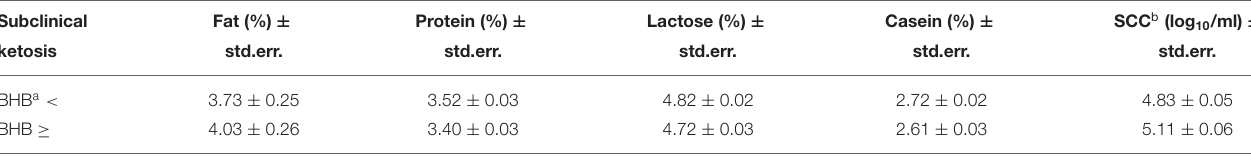
TABLE 3 | Estimated means ( ± std.err.) for milk components values and somatic cell count (SCC) in relation to the BHB values (threshold = 0.10 mmol/L) resulting from HPMIXED analysis for repeated measurements (see Table 2 ). Subclinical